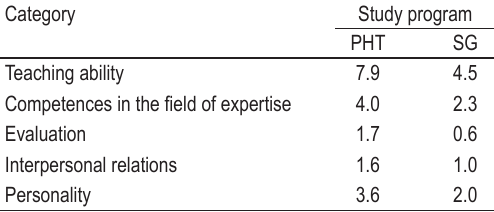
TABLE 3. Differences between the highest and